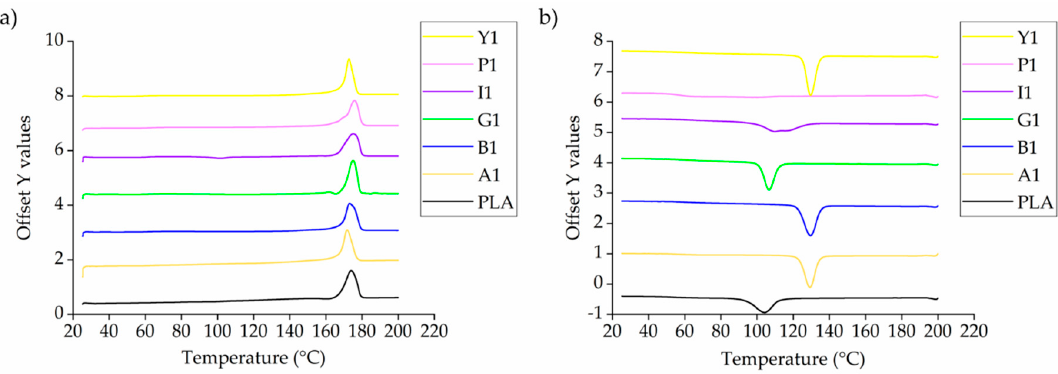
Figure A1. DSC thermograms of PLA and composites containing 1% (w/w) of each additive during ( a ) the heating phase and ( b ) the cooling phase. The DSC thermograms of PLA and the composites containing 3% (w/w) of each additive are presented in Figure A2.